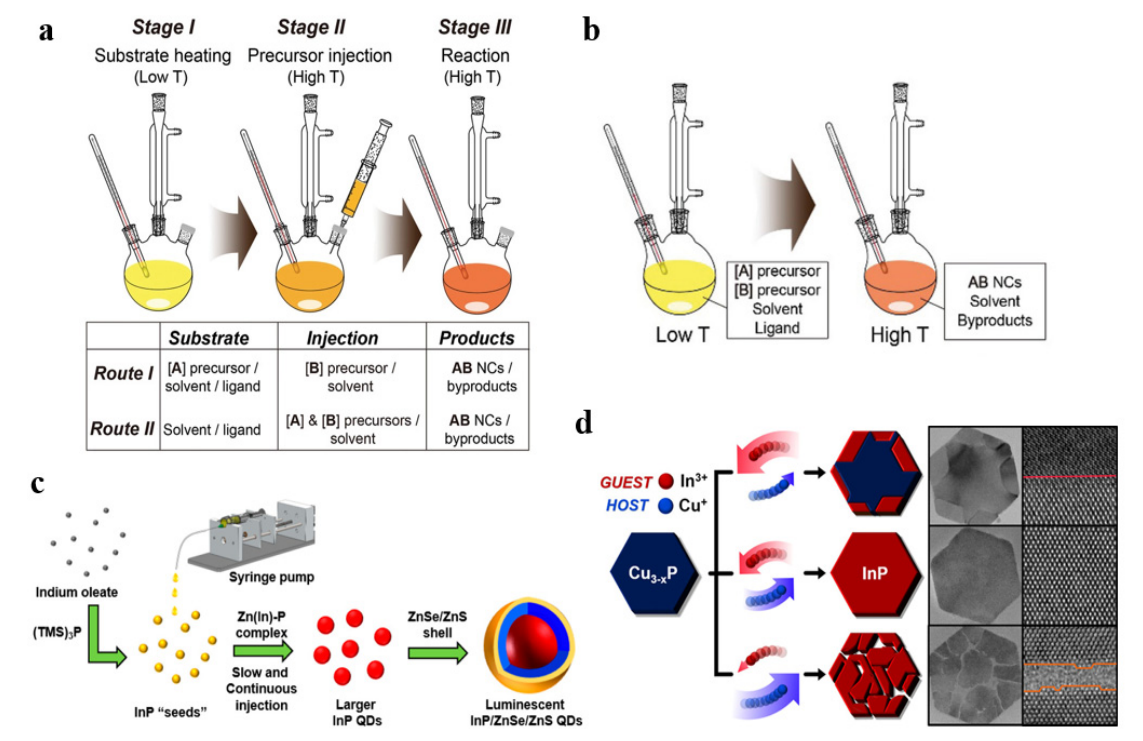
Figure 1. Schematic of QD synthesis by ( a ) hot-injection, ( b ) heat-up (Reprinted with permission from Ref. [46]. © 2020, WILEY-VCH Verlag GmbH & Co. KGaA, Weinheim, Germany), ( c ) seeded growth (Reprinted with permission from Ref. [41]. © 2018, American Chemical Society), and ( d ) cation exchange method (Reprinted with permission from Ref. [44]. © 2019, American Chemical Society). Table 2. Representative synthesis methods of InP QDs and EQE of QLED.